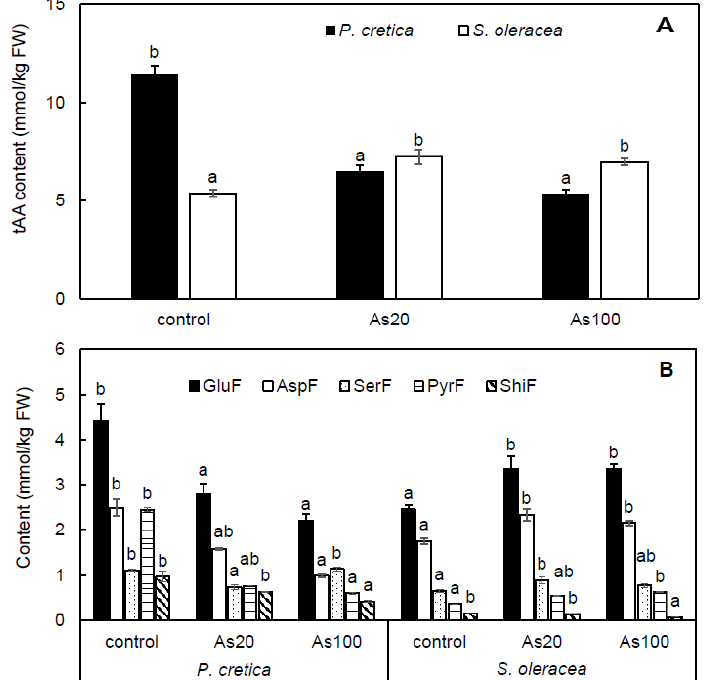
Figure 5. Effect of As treatments on the total content of free amino acids ( A ) and content of individual free amino acid families ( B ) in Pteris cretica and Spinacia oleracea shoots in a pot experiment. Values represent the mean ± SE of three biological and four technical replicates per sample. Data with the same letter are not significantly different. Different letters indicate significant differences ( p ≤ 0.05) among treatments according to the Kruskal-Wallis test. Abbreviations: control—0 mg As/kg soil;